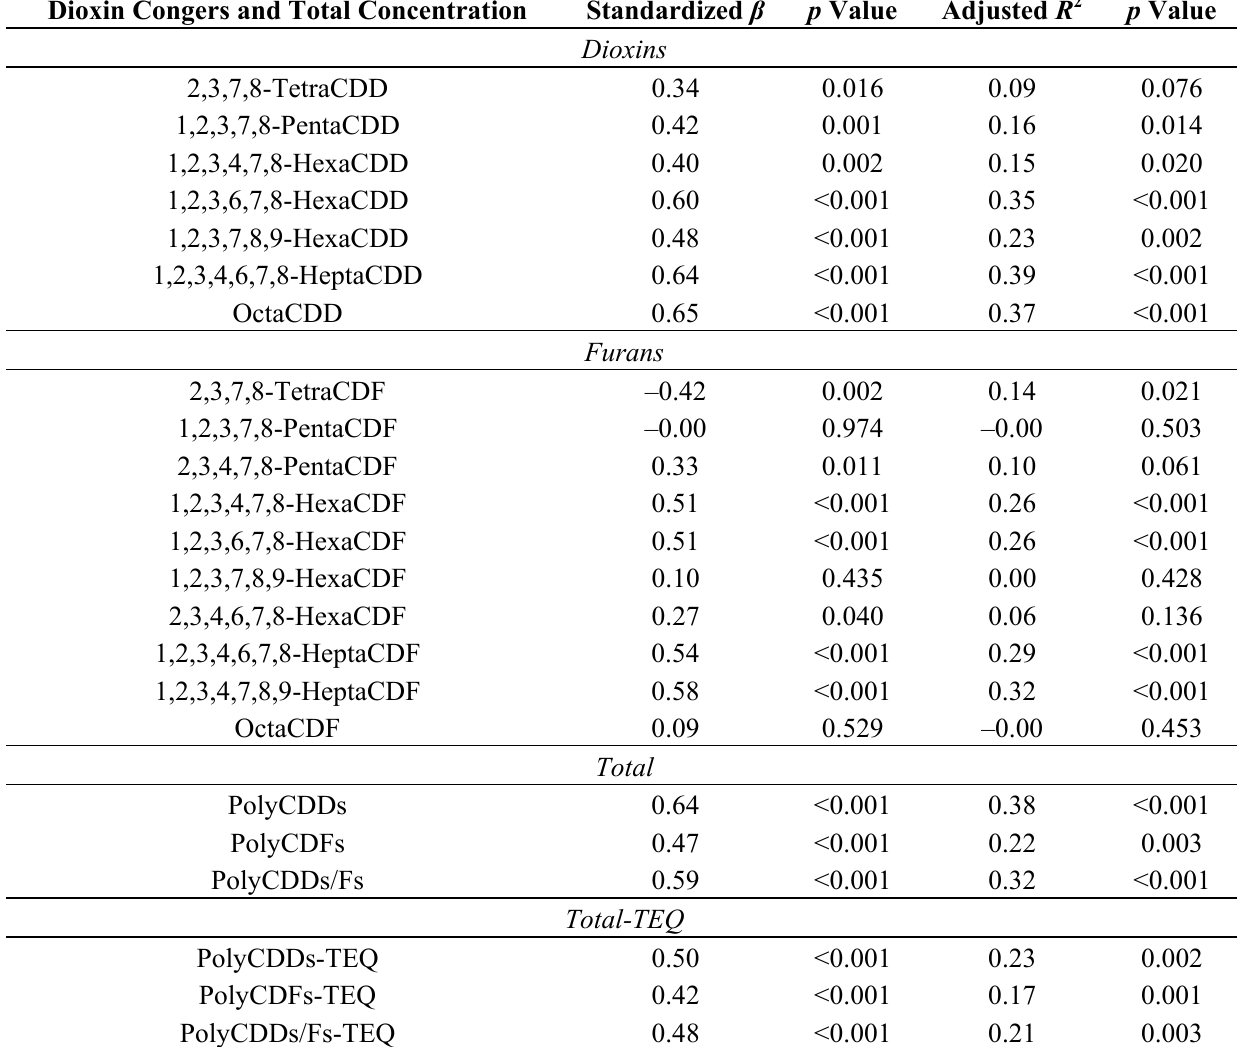
Table 5. Relationship between SCE and each dioxin congeners and total concentration in breast milk as determined by multiple regression analysis ( n =